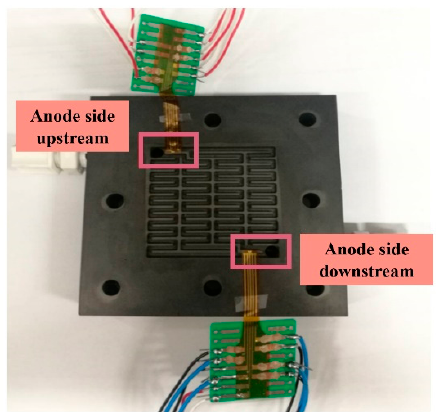
Figure 8. Stereogram of micro hydrogen sensor embedded in proton battery.